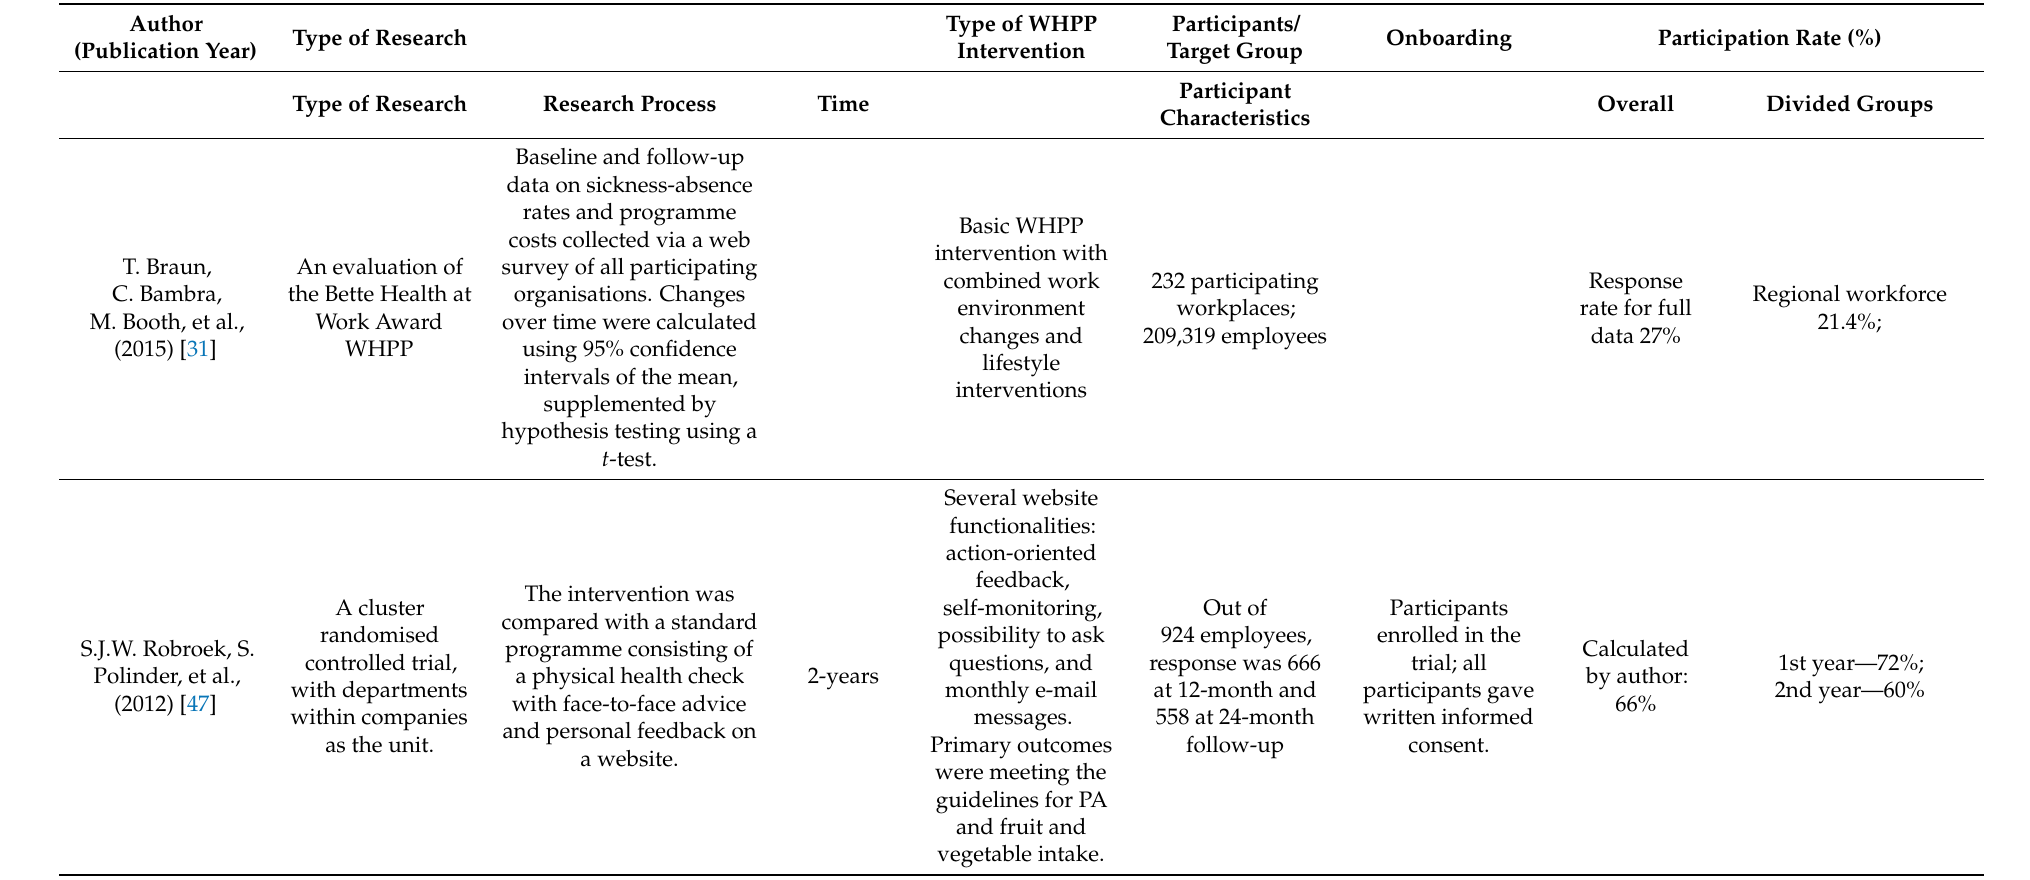
Table 2. WHPP study